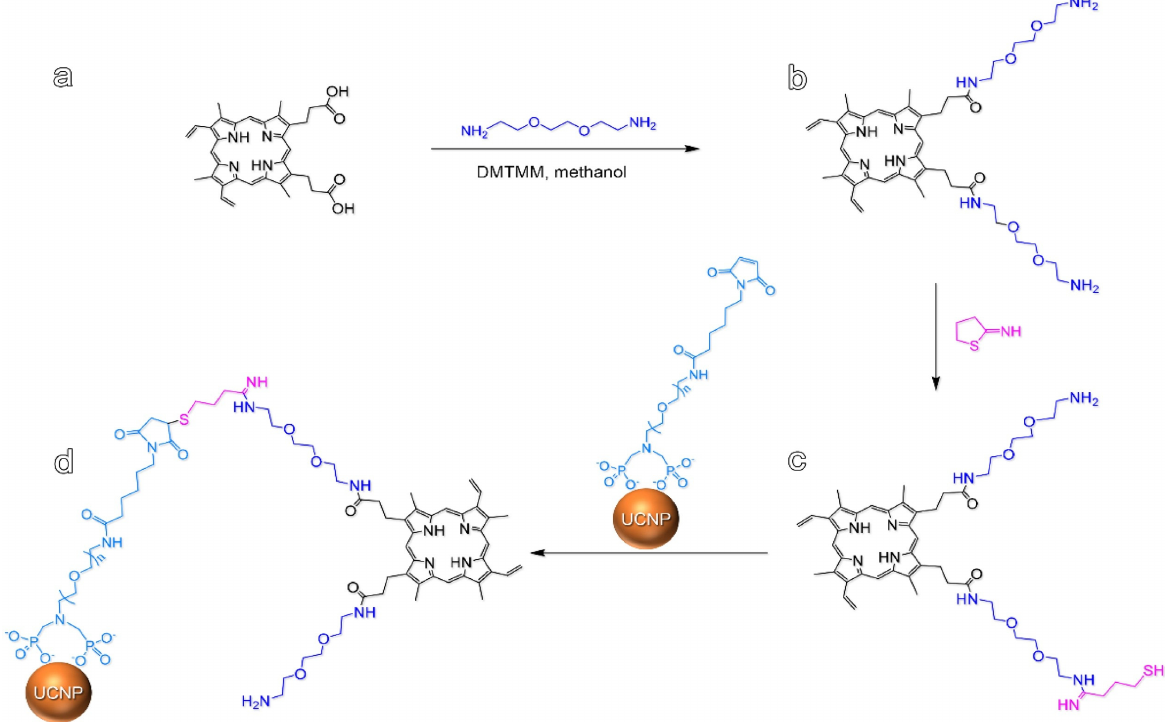
Figure 15. Synthesis routes of a probe based on upconversion nanoparticles (UCNPs). PpIX ( a ), porphyrin-jeffamine (PJ) ( b ), thiolated porphyrin-jeffamine ( c ), and the UCNPs–PJ probe ( d ) [96].